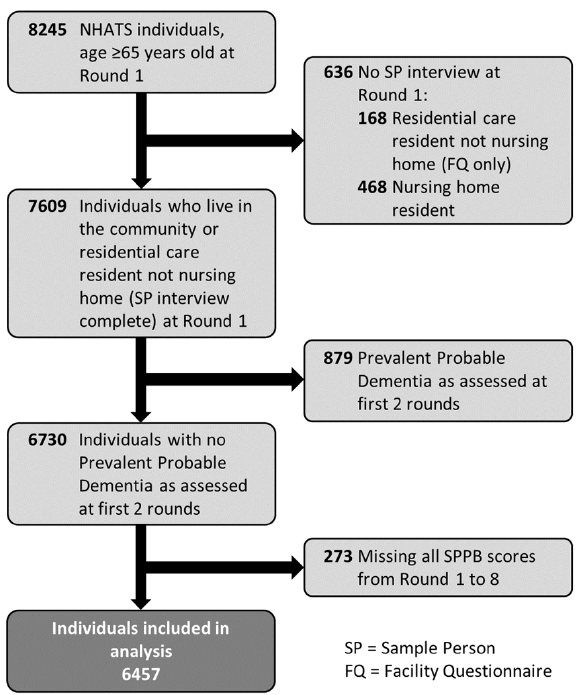
Figure 1. Flow diagram of study participant inclusion .